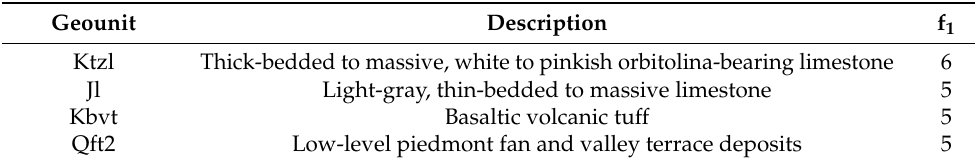
Table 1. Cont. Geounit